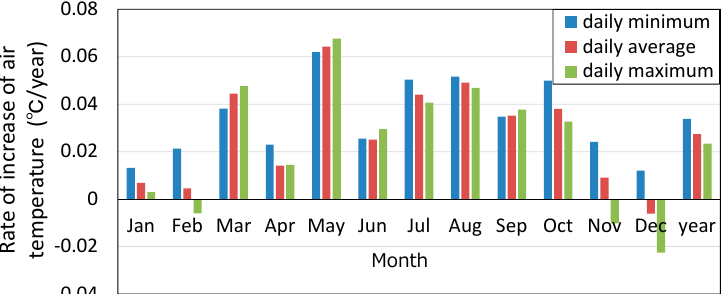
Figure 10. Rate of increase over time in monthly averages of air temperature (1990 − 2019). Air temperature: same as Figure 9. Rate of increase in air temperature: slope of linear regression line for the monthly average temperature for each month over 30 years.